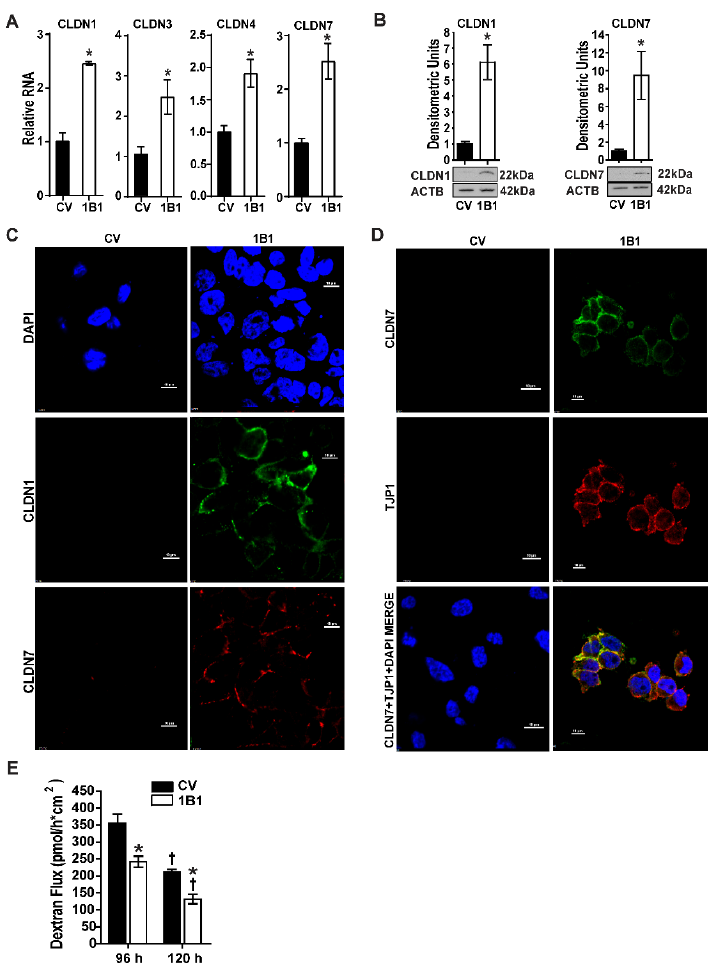
Figure 2. CYP1B1 suppression is associated with increased expression of claudins in CL triple- negative breast cancer (TNBC) cells. ( A ) qPCR analysis of CLDN1, CLDN3, CLDN4, and CLDN7 transcripts. Values are the mean ± SD, n = 3, relative to CV, set at a value of 1.0. The * indicates a significant difference ( p ≤ 0.05) between CV and CYP1B1 KD cells by Student’s t- test. ( B ) Protein levels of CLDN1 and CLDN7. CLDN1 and CLDN7 densities were normalized to ACTB. Values are the mean ± SD, n = 3, relative to CV The * indicates a significant difference ( p ≤ 0.05) between CV and CYP1B1 KD by Student’s t- test. ( C ) Confocal microscopic images of CV and CYP1B1 KD cells; CLDN1 (green) and CLDN7 (red) immunofluorescent staining. Nuclei were visualized with DAPI (blue), magnification 600×, scale bar, 10 µm. See methods for instrument parameters. ( D ) Confocal microscopic images of CV and CYP1B1 KD cells; CLDN7 (green) and TJP1 (red) immunofluorescent staining. Nuclei were visualized with DAPI (blue). Representative confocal microscopic images at 600× magnification, scale bar, 10 µm. ( E ) Paracellular permeability measured in CV or CYP1B1 KD cells cultured for 96 h or 120 h. Values are the mean ± SD, n = 3. The * indicates a significant difference between CV and CYP1B1 KD cells at the same time point, and the † indicates a significant between 96 h and 120 h of the same cell line; p ≤ 0.05 using two-way ANOVA followed by Tukey’s multiple comparisons.